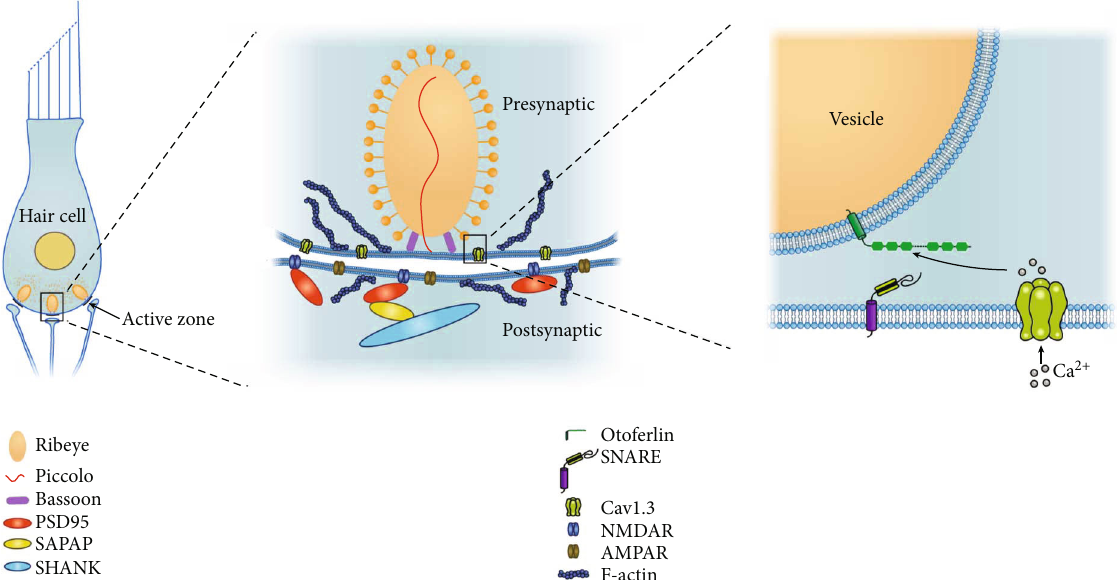
Figure 1: Schematic of the cochlear IHC